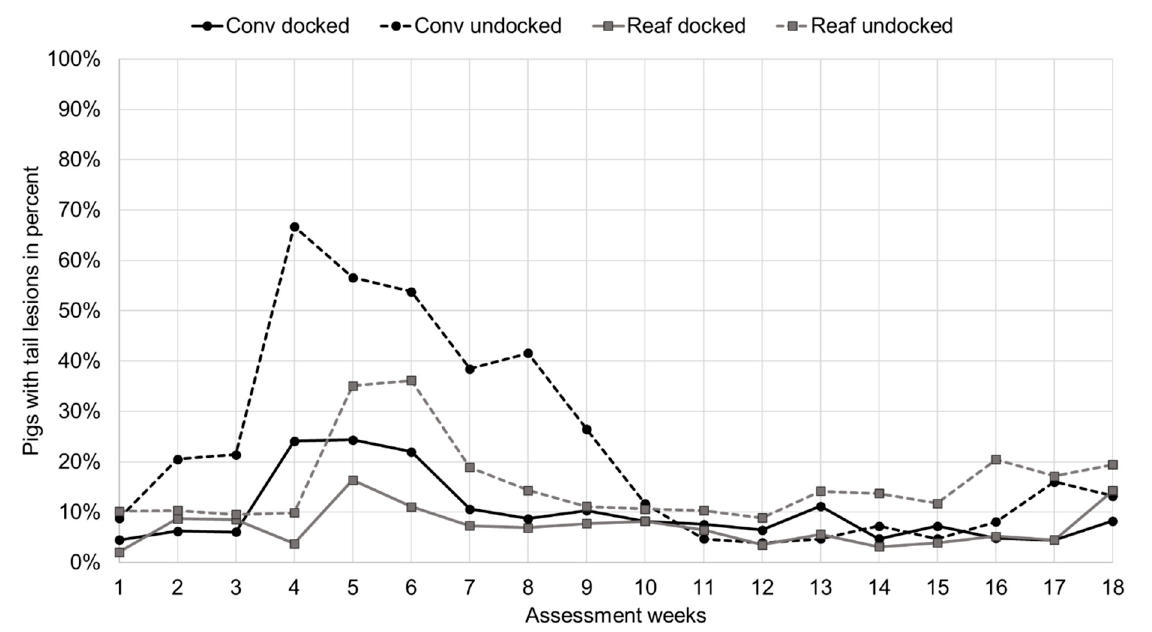
Figure 4. Frequency in the percentage of back transformed tail lesion estimates for docked and undocked pigs per rearing system over 18 assessment weeks (Conv: conventional rearing, Reaf: rearing in the farrowing pen). For a better clarity of the figure, significances are shown in Table 2. Table 2. Multiple comparison of the least-square means differences of the interaction assessment week × rearing system × docking status by Bonferroni within the assessment week ( p < 0.05).